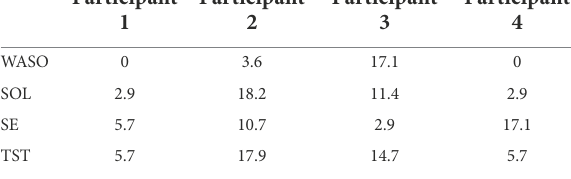
TABLE 2 The percentage of all non-overlapping data (PAND) for wake after sleep onset (WASO), sleep onset latency (SOL), total sleep time (TST) and sleep efficiency